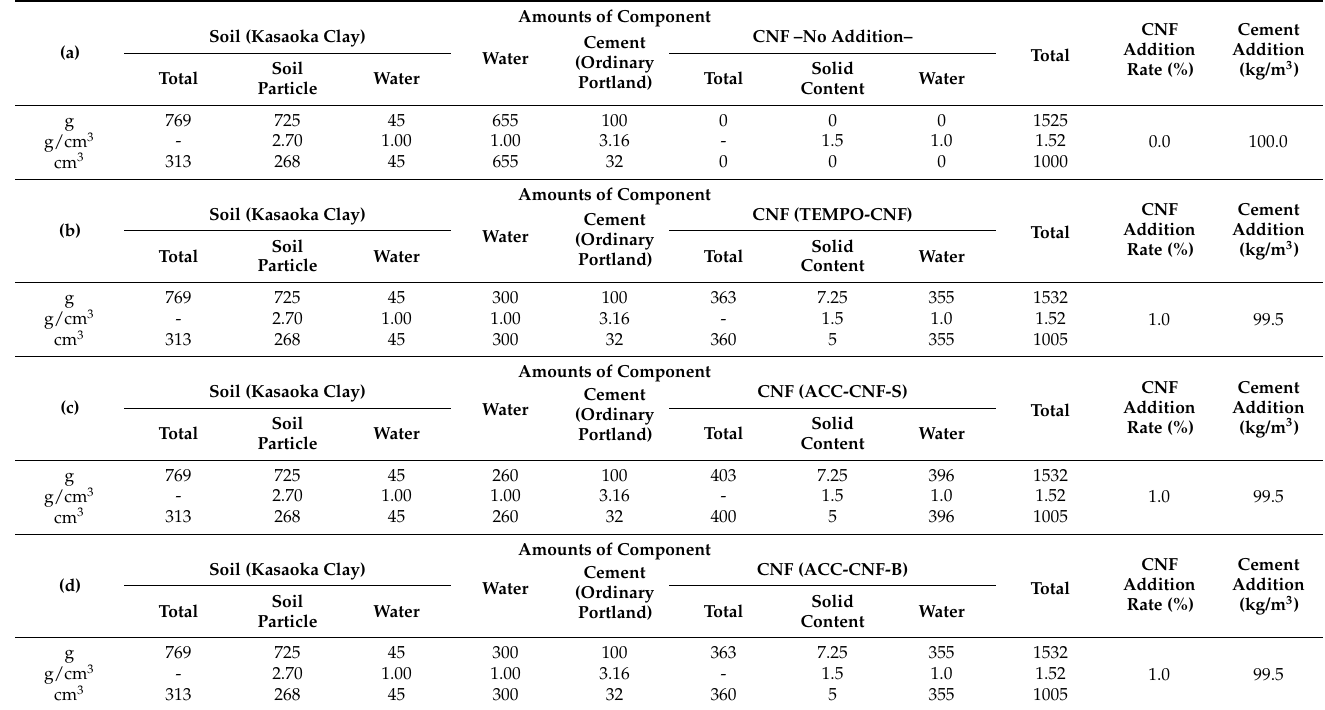
Table 3. Mix proportion of cement, CNF, water, and soil in Method 1: ( a ) Treated soil without CNF; ( b ) Treated soil with TEMPO-CNF (Gel); ( c ) Treated soil with ACC-CNF-S; ( d ) Treated soil with ACC-CNF-B.